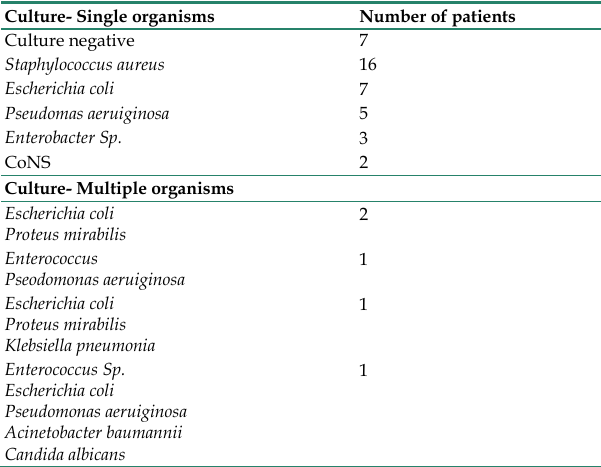
Table 1. Tissue culture results Culture- Single organisms Number of patients Culture